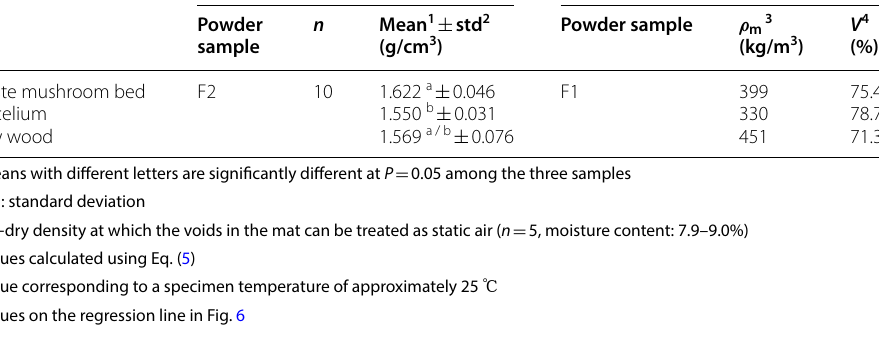
Table 3 Values used in model calculations and the optimal substance thermal conductivity (cid:31) s